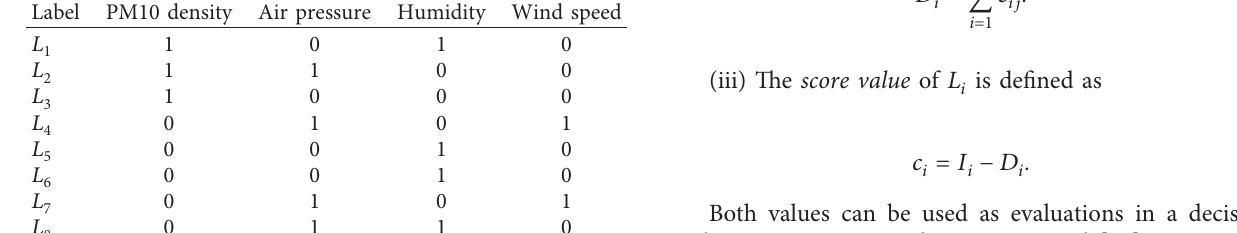
Table 1: Tabular presentation of the soft set in Example 1. Label PM10 density